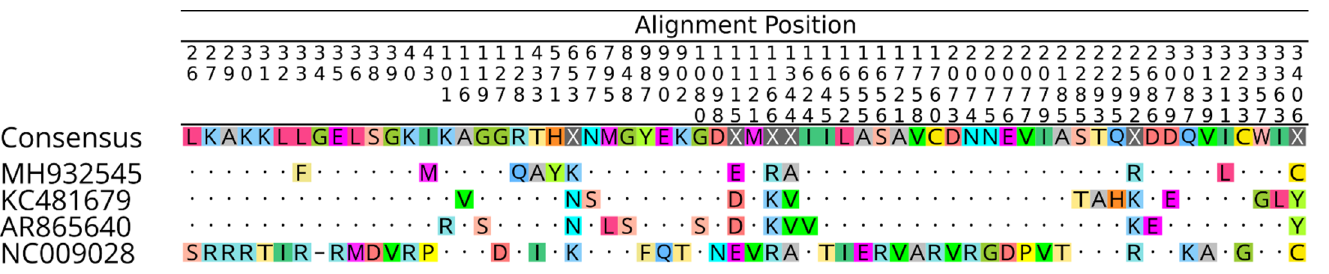
Figure 3. Alignment between the coding region of the isolate BeAr865640 and the coding regions of three complete ILHV sequences available at the NCBI. Table 4. Nucleotide and amino acid identity matrix between the complete sequence of isolate BeAr865640 and three complete sequences of ILHV available on GenBank. Sequence (Id. GenBank)